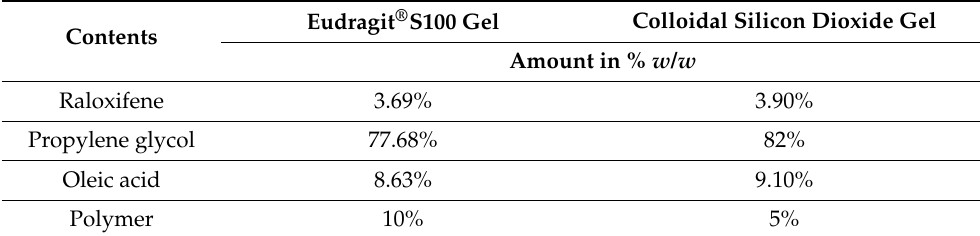
Table 1. Composition of polymeric transdermal gels for